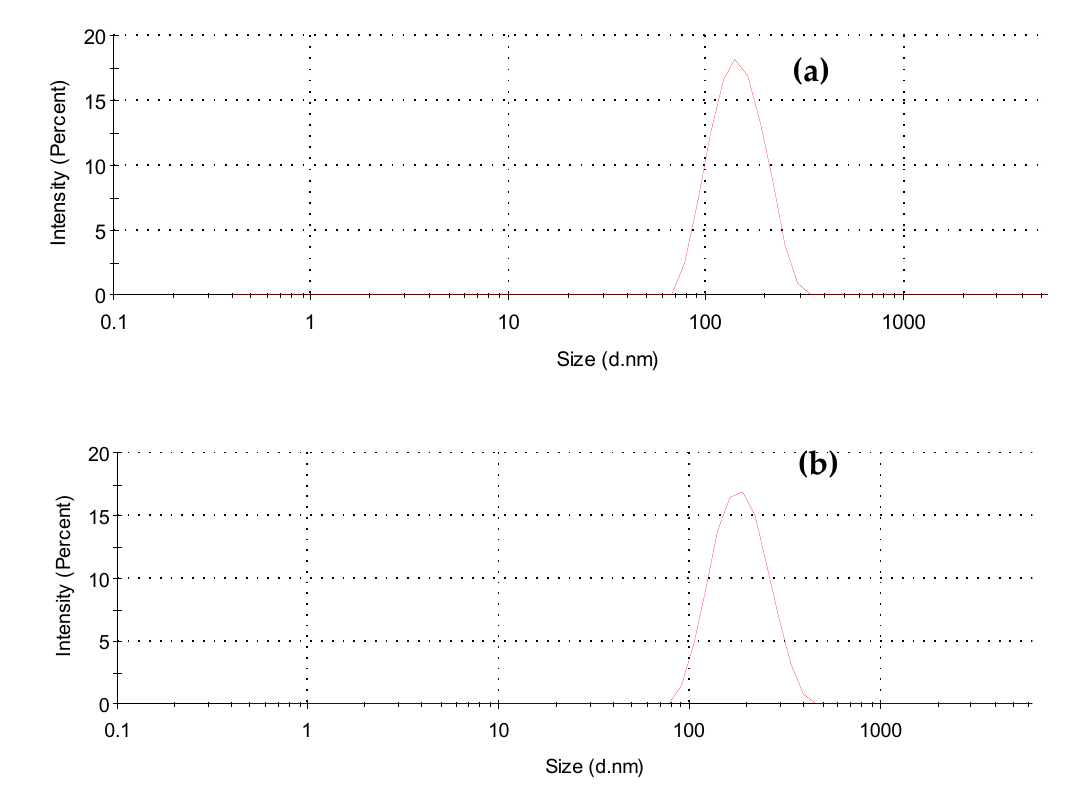
Figure 3. Particle size distribution for ( a ) blank (144.5 nm, PDI = 0.207) and ( b ) IgG loaded AZP nanospheres (185.5 nm, PDI = 0.190).